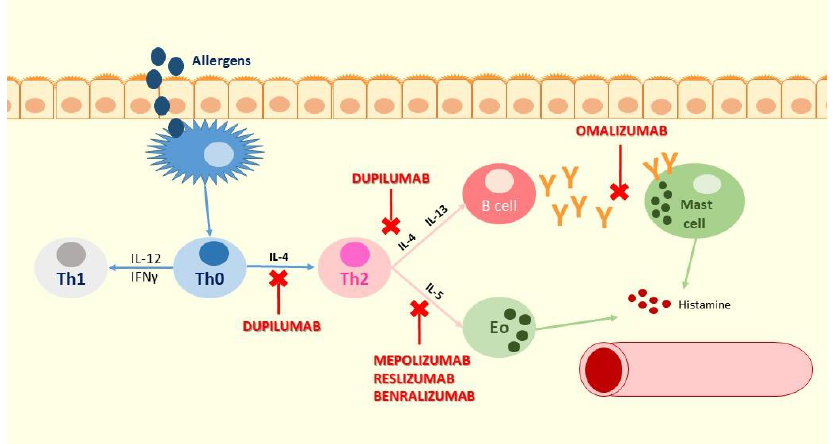
Figure 1. The point of action of the inhibitory activity of the mentioned biologic